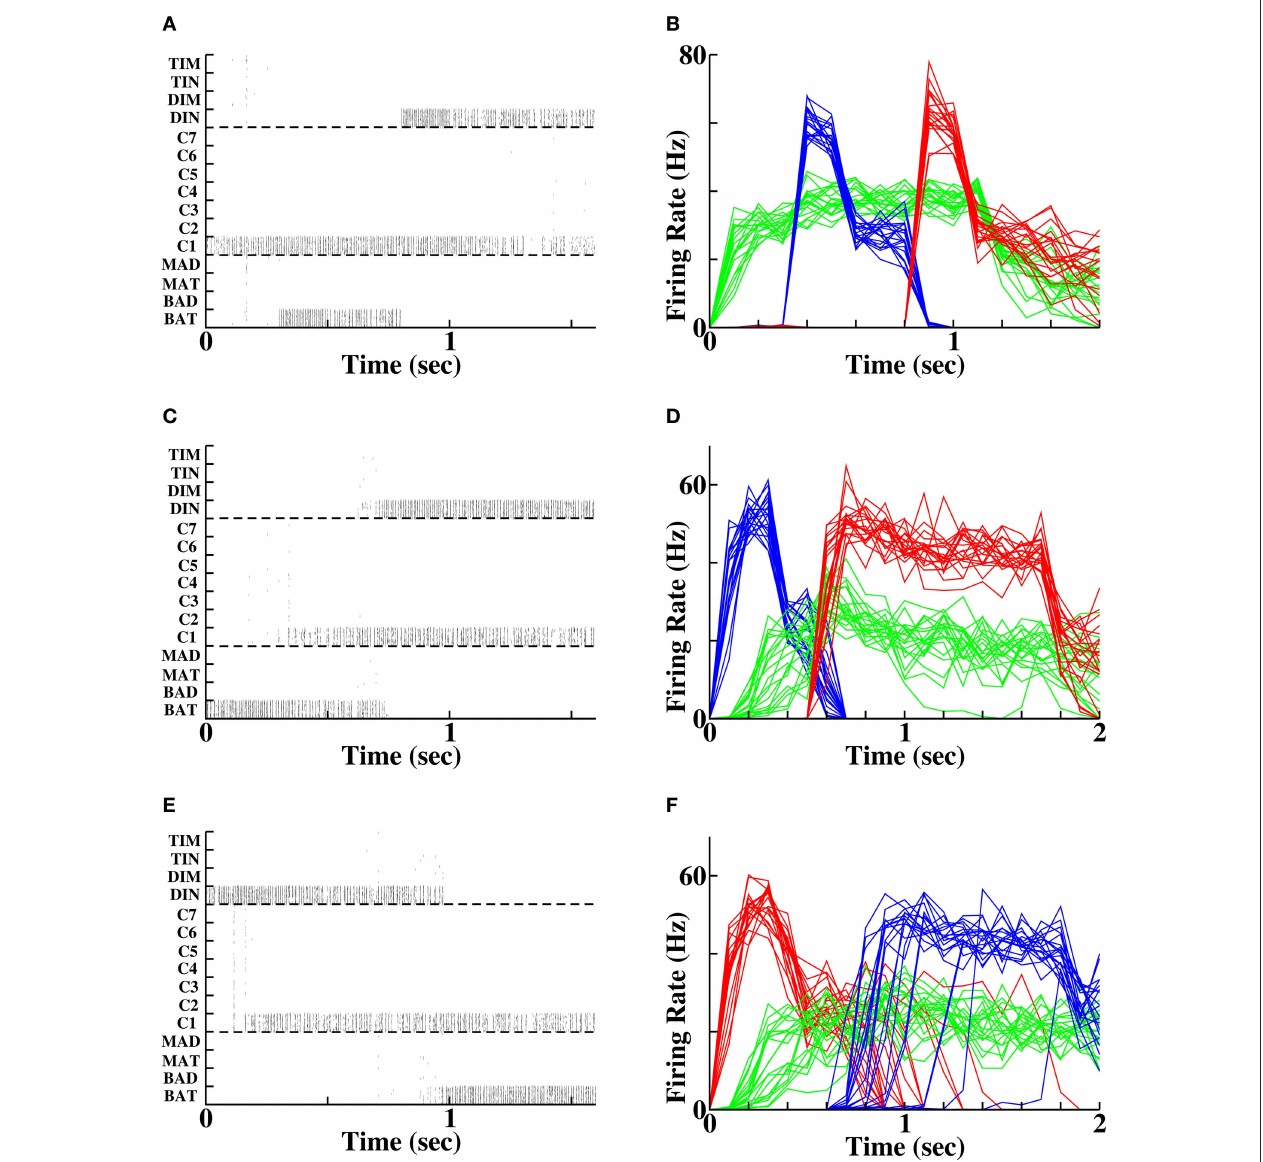
group is activated prior to the first word activation until 100 ms following the end of second word activation. (C, D) Forward recall. The first word, (“BAT”) is reactivated. Activity in the context pool (“C1”) is retrieved without external input. Non-specific excitation to all other word populations produces a recall of the second word (“DIN”). (e, F) Reverse recall. The second word (“DIN”) is reactivated. Activity in the population of cells retrieves activity in the context pool (“C1”), which upon non-specific excitation retrieves activity in the first word population